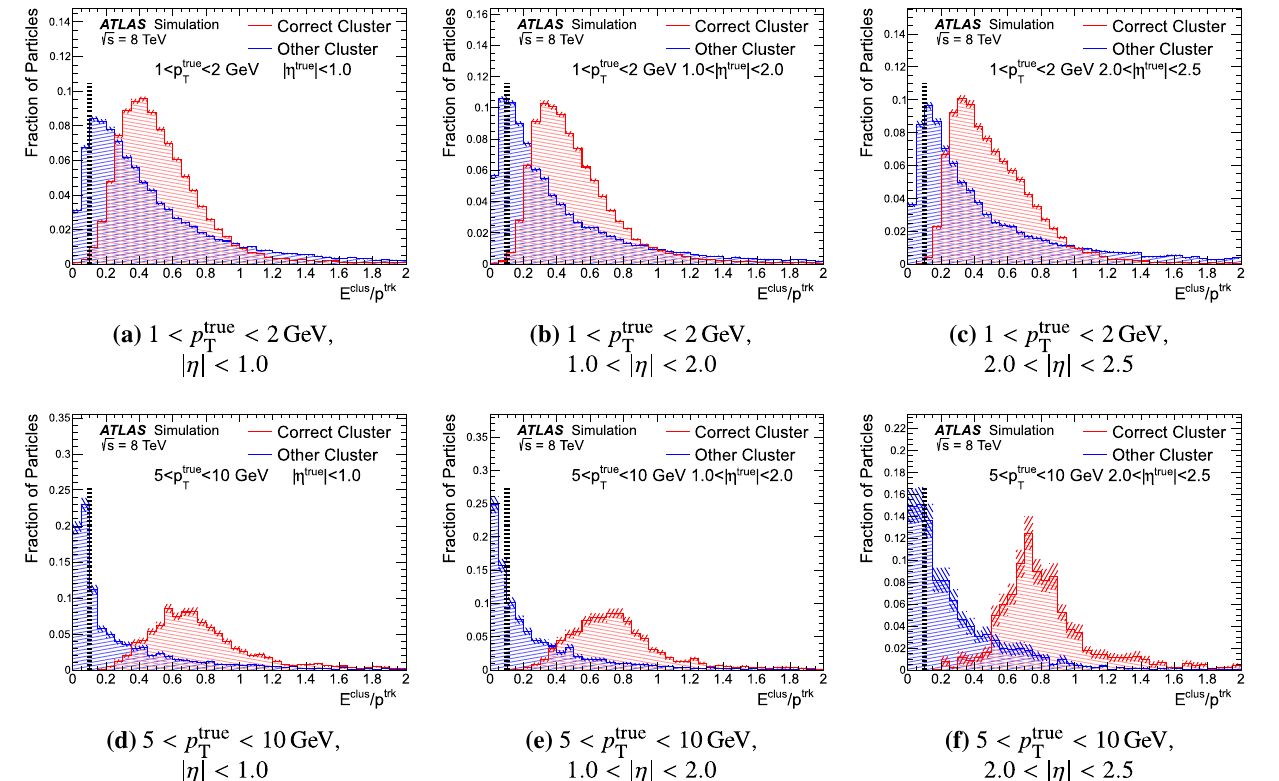
Fig. 11 The distributions of E clus / p trk for the topo-cluster with > 90% of the true energy of the particle and the closest other topo-cluster in (cid:8) R (cid:8) . The data are taken from a dijet sample without pile-up with < 500GeV and the statistical uncertainties on the number 20 < p lead T